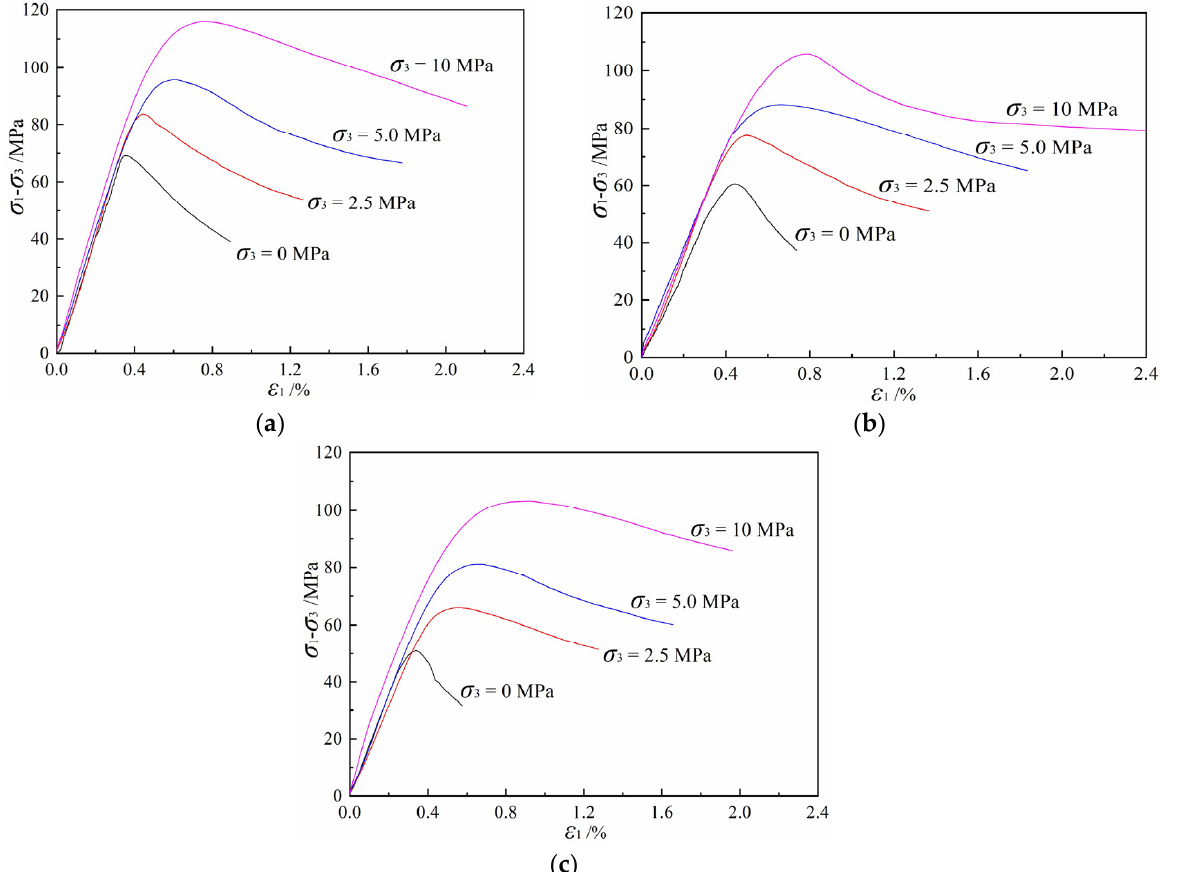
Figure 6. Triaxial stress–strain curves of RAC under different curing conditions. ( a ) RAC20, ( b ) RAC6012, ( c ) RAC8009.